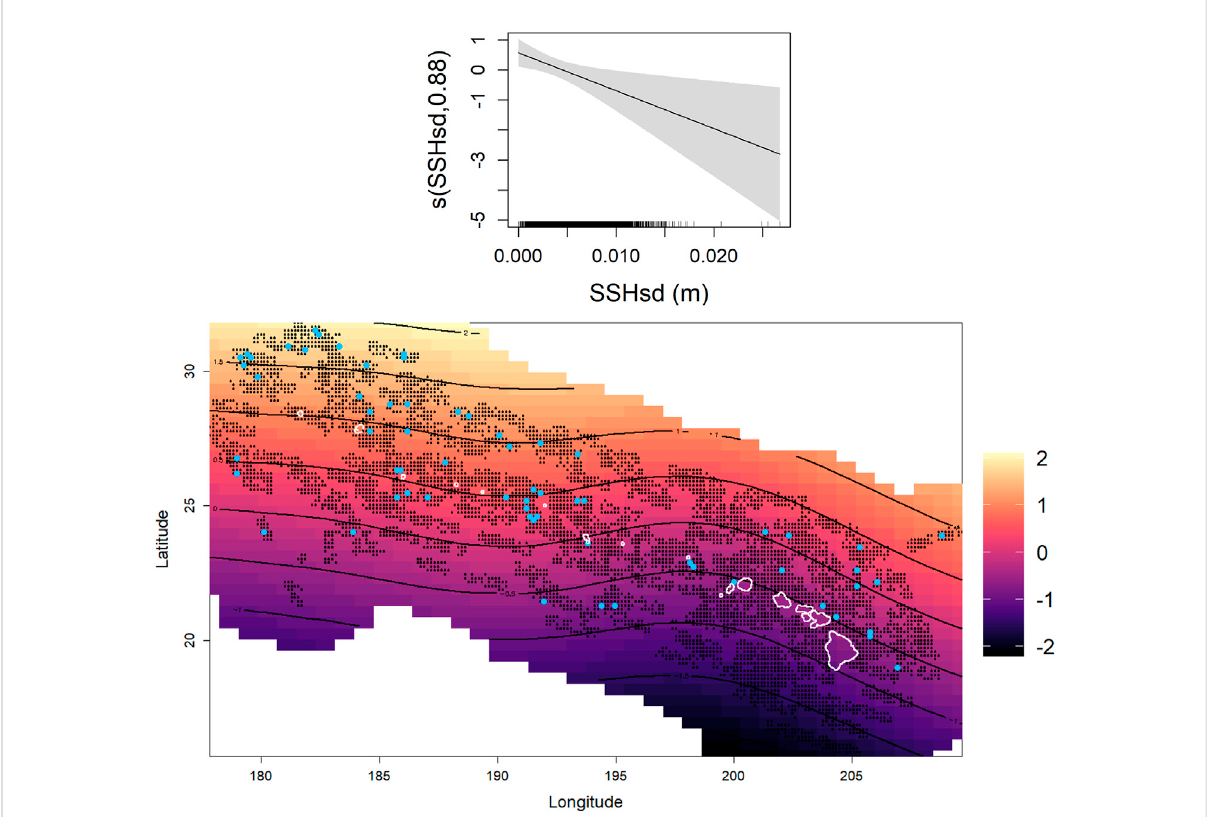
FIGURE 6 Environmental predictors selected for the non-foraging model included the standard deviation of sea surface height and the 2D spatial term (Longitude, Latitude). Light blue dots on the heat map of the spatial term represent all encountered non-foraging sperm whale groups and the black dots indicate all surveyed areas included in the model. The black contour lines represent predicted number of whale groups on the link scale and correspond with the color scale, increasing from dark to light